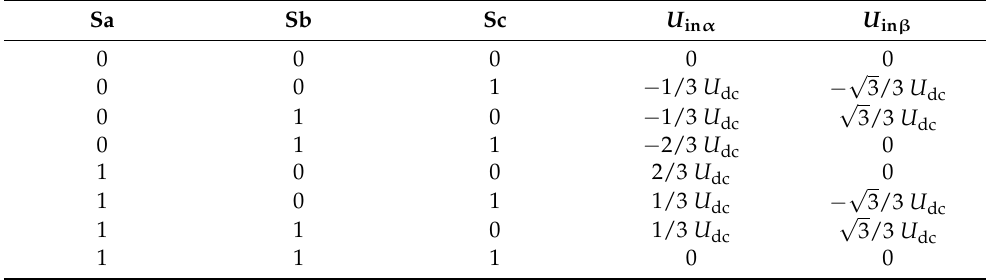
Table 1. Switching state and inverter output voltage vector corresponding